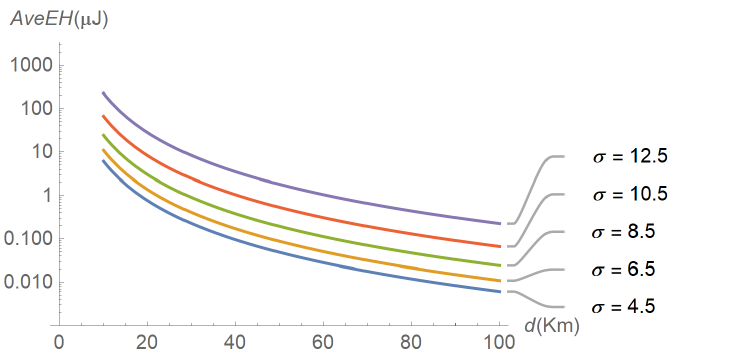
Figure 7. Evolution of the average energy harvested as a function of distance, for different levels of shadowing spread and a path-loss exponent equal to